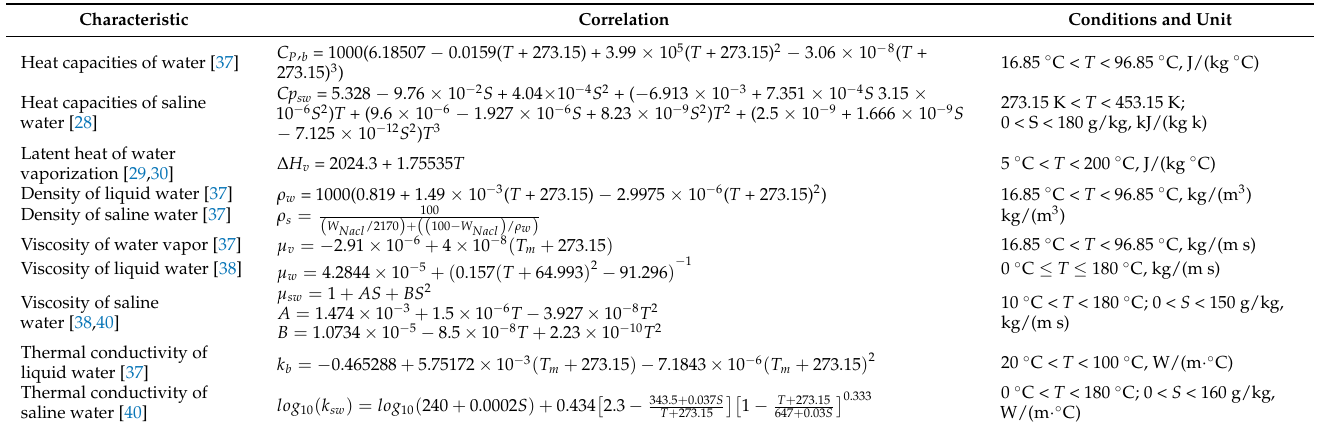
Table 2. Correlation equations of the pure water and saline water.